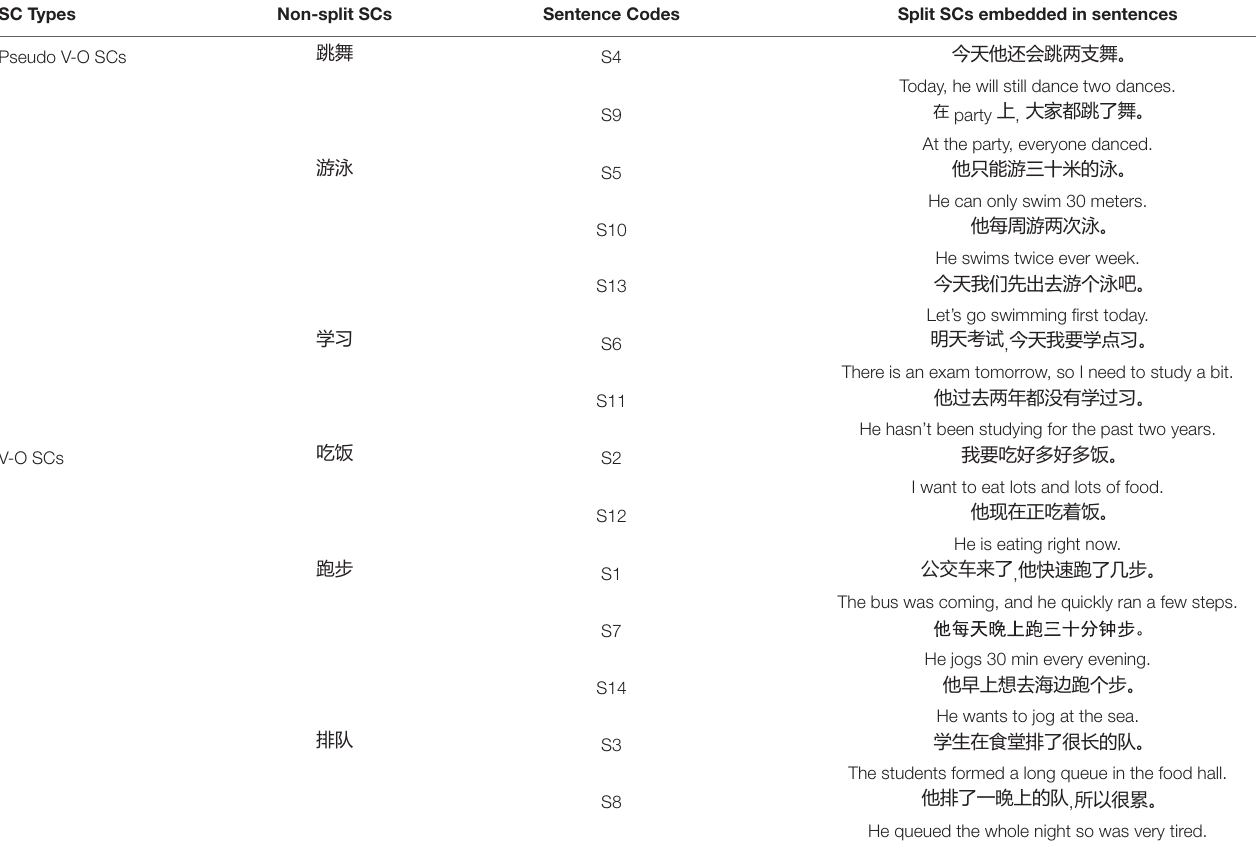
TABLE 1 | Testing materials.